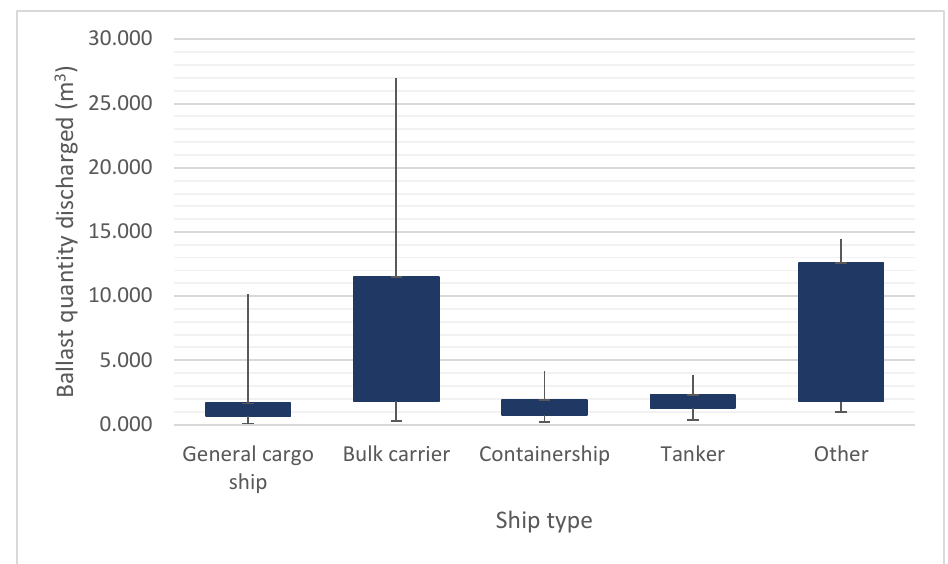
Figure A4. Annual frequency of ship calls by ship type.